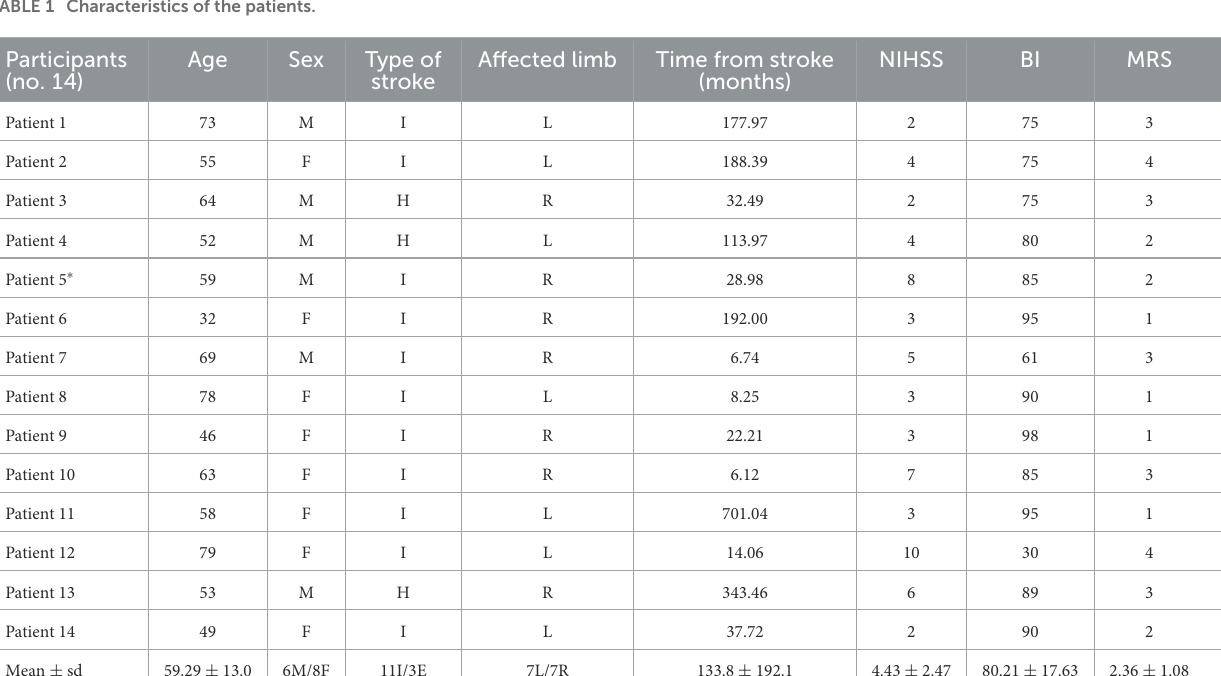
TABLE 1 Characteristics of the